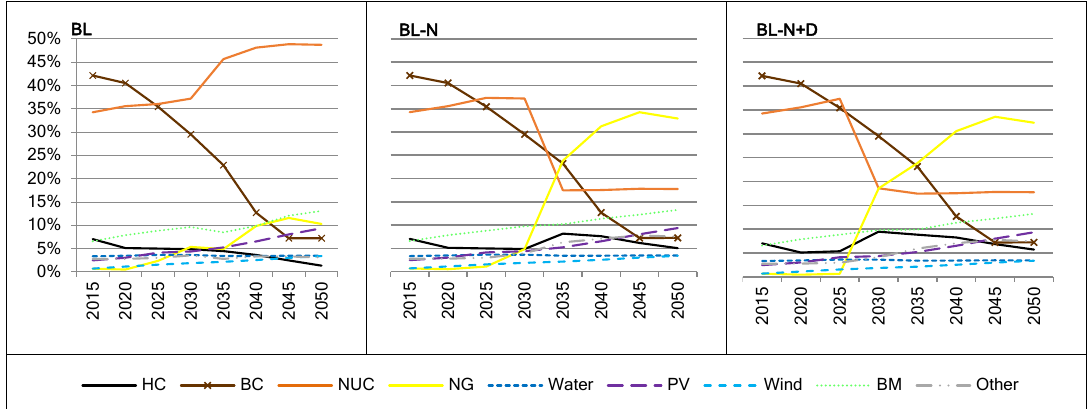
Figure 3. Fuel shares in power generation in the TEL1 variant for the three baseline assumption sets defined by a decision on a new nuclear power plant. Note: HC—hard coal, BC—brown coal, NUC—nuclear, NG—natural gas, PV—photovoltaics, BM—biomass &